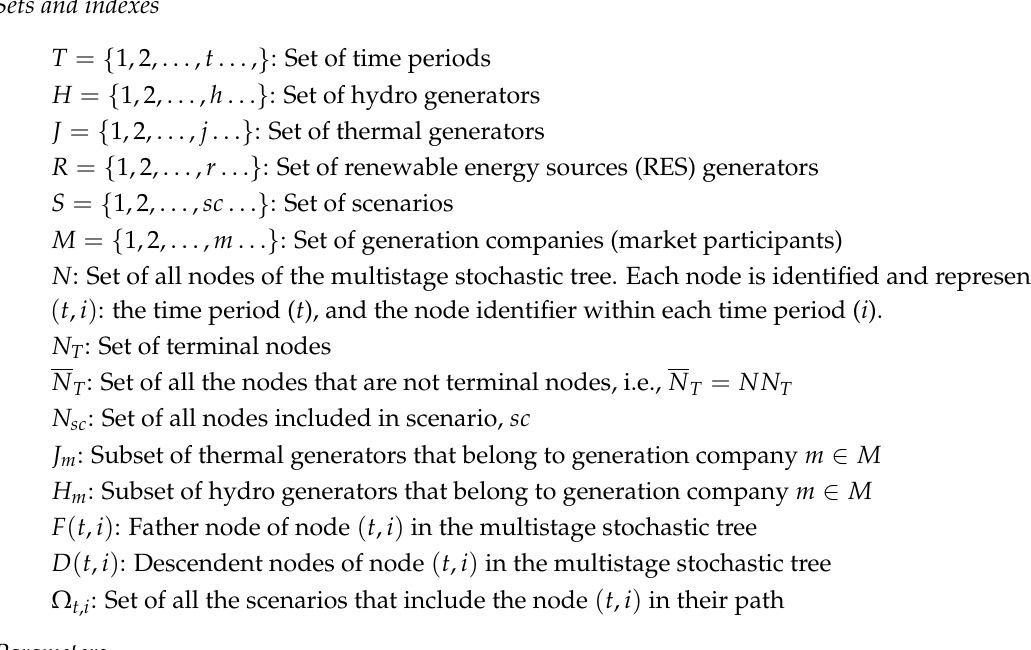
Table S1: Duration of each month; Table S2: Structure of the stochastic tree; Table S3: Data of the stochastic variables (RES, Demand, Inflows, and Fuel Cost